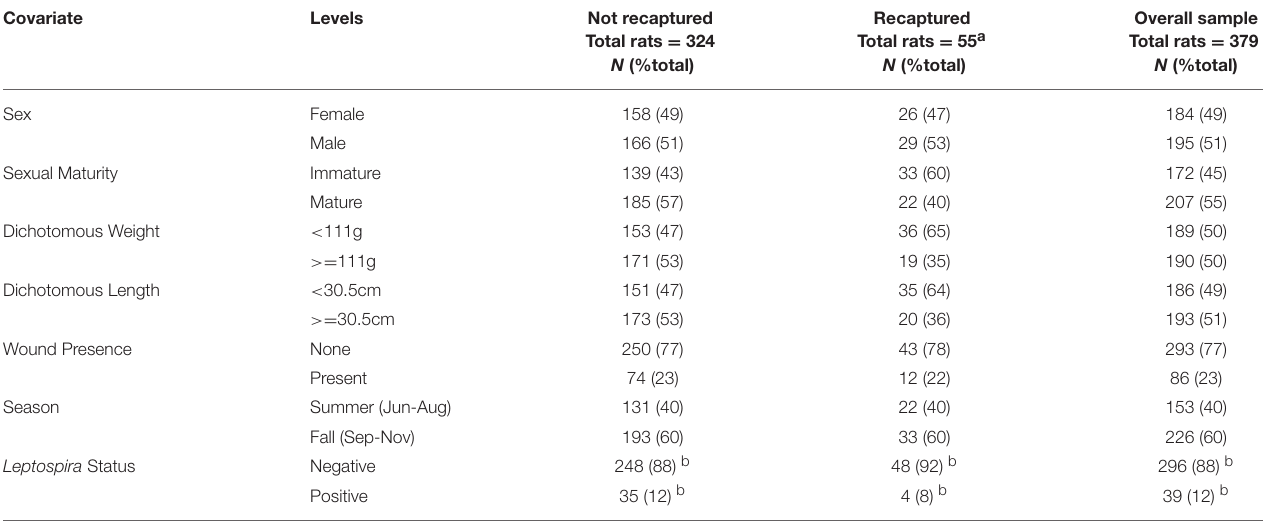
TABLE 1 | Descriptive statistics of captured urban Norway rats ( Rattus norvegicus ). Covariate